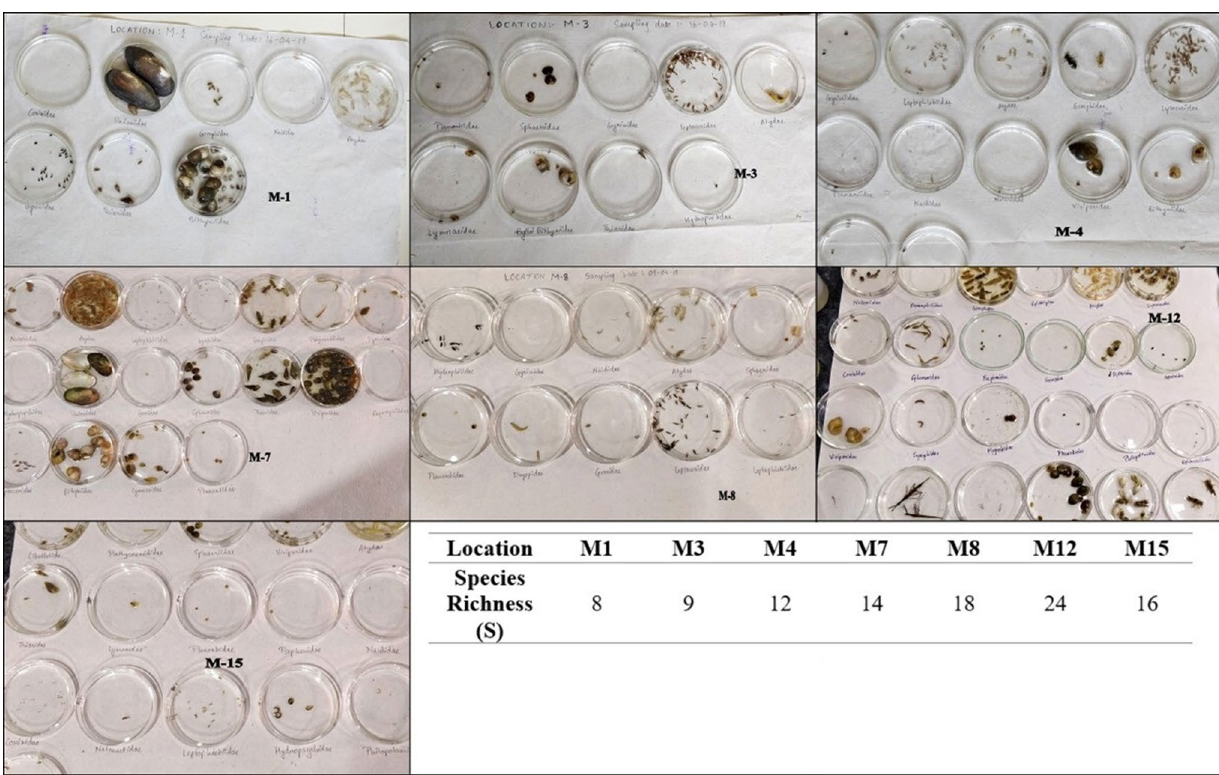
Fig. 5 Species richness at different locations of the study